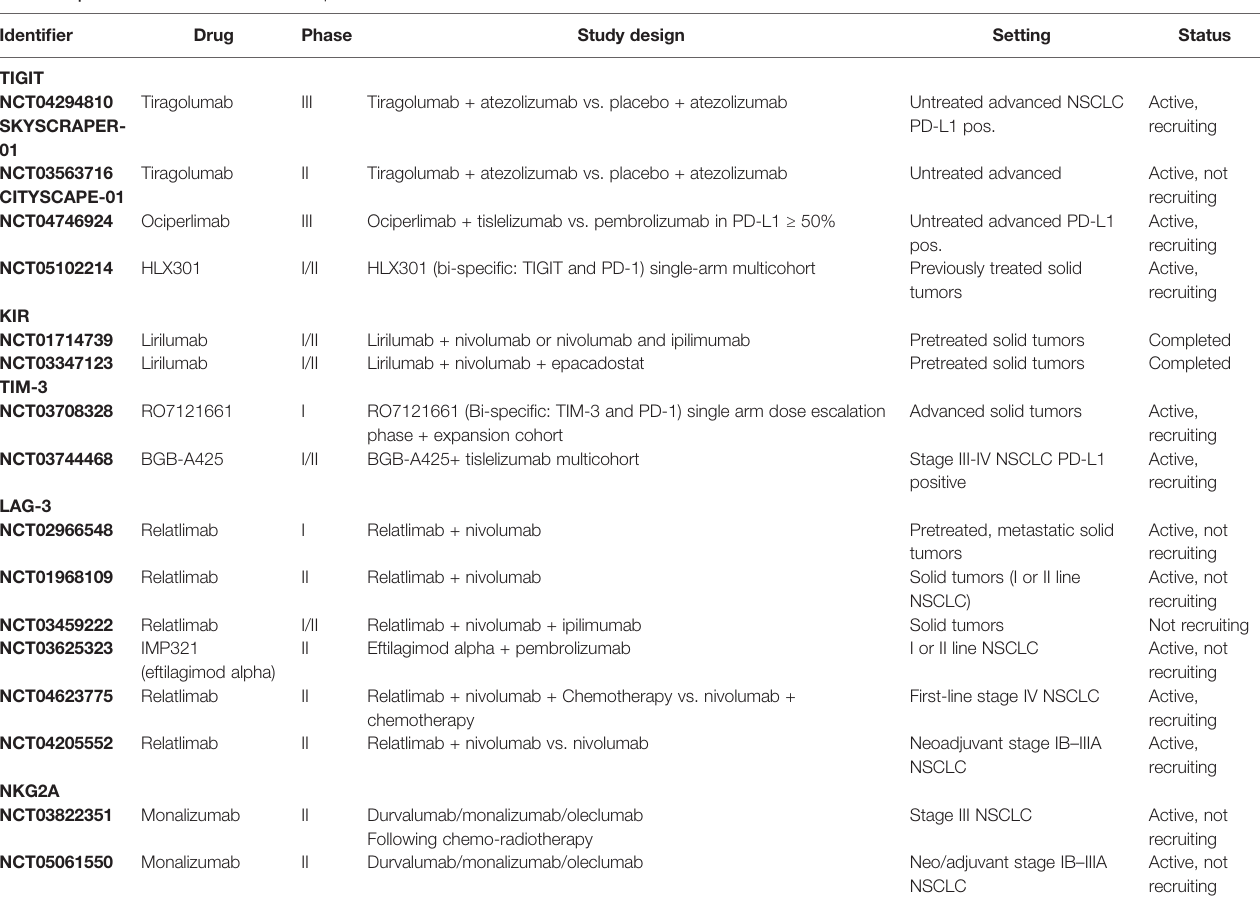
TABLE 1 | Current clinical trials with checkpoint inhibitors in